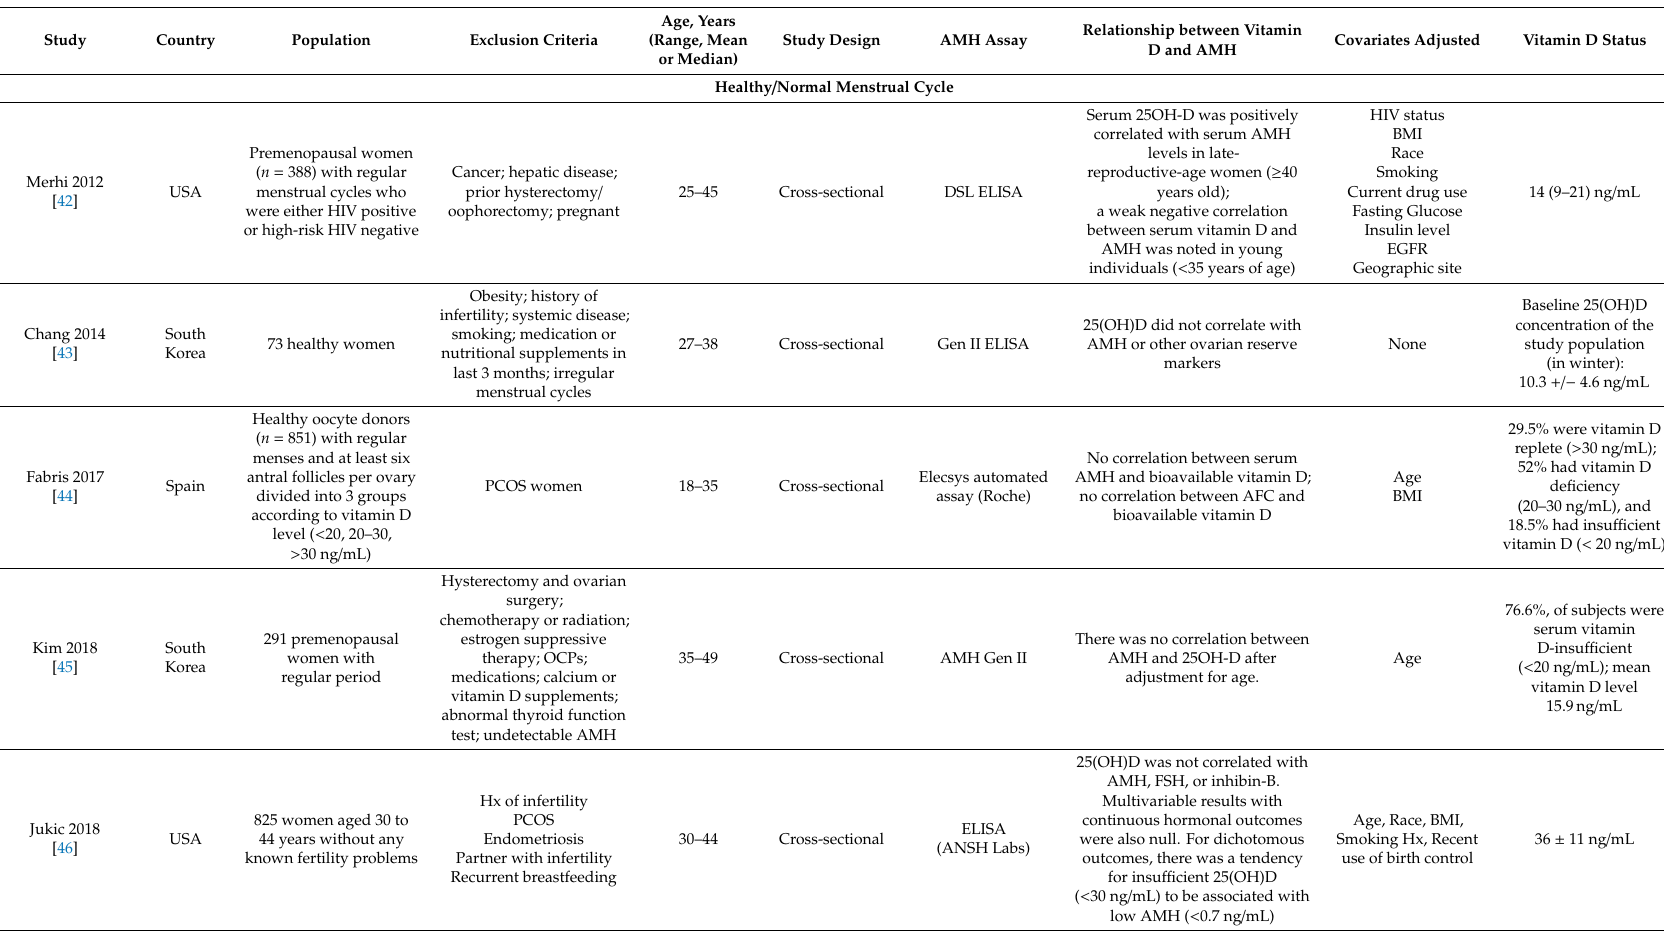
Table 1. Observational